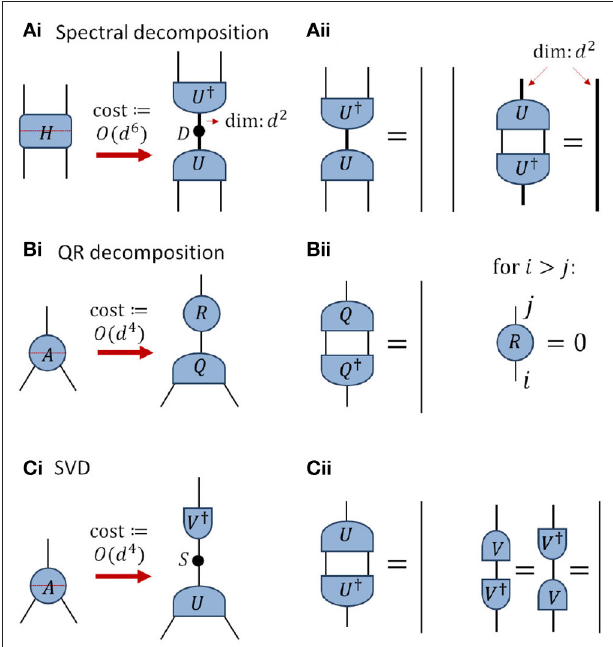
FIGURE 4 | Depiction of some common matrix decompositions. All indices are assumed to be of dimension d unless otherwise indicated. (Ai) The spectral decomposition is applied to the order-4 Hermitian tensor H across the partition indicated by the dashed line, yielding a diagonal matrix of eigenvalues D and a unitary U . (Aii) The unitary tensor U annihilates to identity with its conjugate, as per Equation (6). (Bi) The QR decomposition is applied to the order-3 tensor A across the partition indicated, yielding an isometry Q and an upper triangular matrix R . (Bii) The isometry Q annihilates to identity with its conjugate as per Equation (7), while the R matrix is upper triangular. (Ci) The singular value decomposition (SVD) is applied to the order-3 tensor A across the partition indicated, yielding an isometry U , a diagonal matrix of singular values S , and a unitary V . (Cii) Depiction of the constraints satisfied by